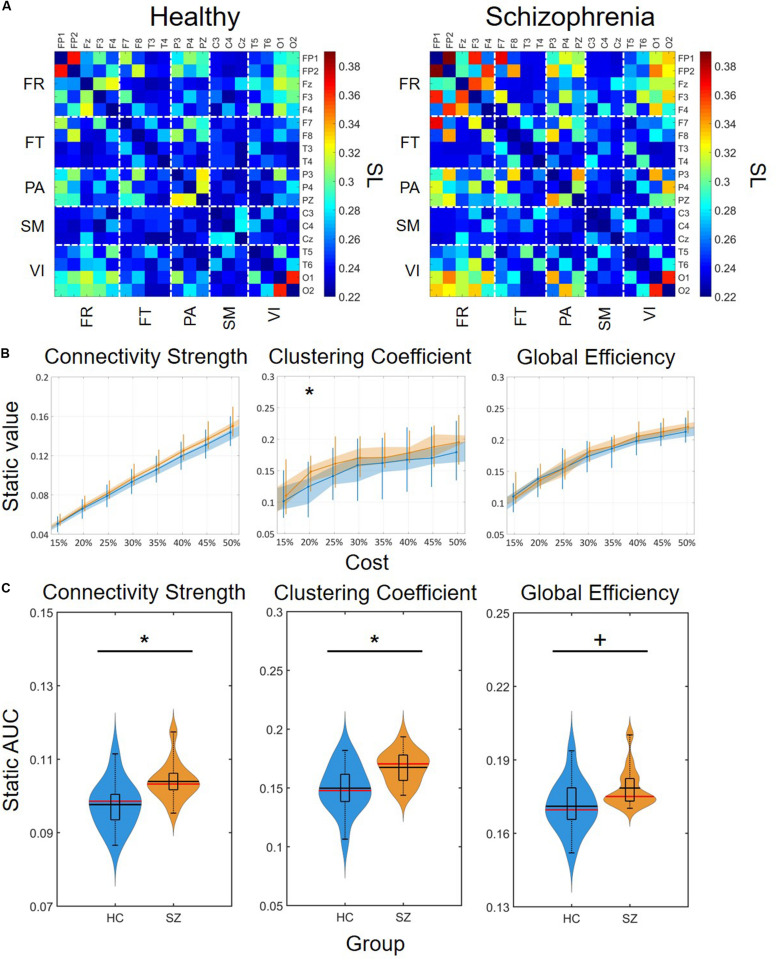
Group-average connectivity matrices and results of static functional connectivity analysis. (A) Group-average static connectivity matrices for healthy controls (left) and patients with schizophrenia (right). For a better comparison, the matrices are in the same color scale. Channels are grouped according to macroanatomical brain regions. (B) Results of the cost-dependent analysis. Data corresponding to healthy controls is marked in blue, while those of patients with schizophrenia are marked in orange. Dots mark median values, the shaded area refers to the 25th and 75th percentiles, and vertical lines range from 10th to 90th percentiles. Asterisk marks significant group difference (p < 0.05, corrected) acquired with two sample t-test. (C) Violin plots of static FC results for all three network measures. In each violin plot the central black line indicates the mean and the central red line indicates the median. The lower and upper horizontal lines of the rectangle mark the 25th and 75th percentile, respectively, and the outer horizontal lines indicate the 10th and 90th percentile values. The colored areas illustrate the estimated probability density function of the corresponding datasets. An asterisk marks significant group difference (p < 0.05) identified with two-sample t-test, while a plus sign marks significant difference identified with Mann-Whitney U-test. SL, synchronization likelihood; FR, frontal cortex; FT, frontotemporal regions; PA, parietal cortex; SM, somatomotor cortex; VI, visual cortex; AUC, area under the curve; HC, healthy control; SZ, schizophrenia.